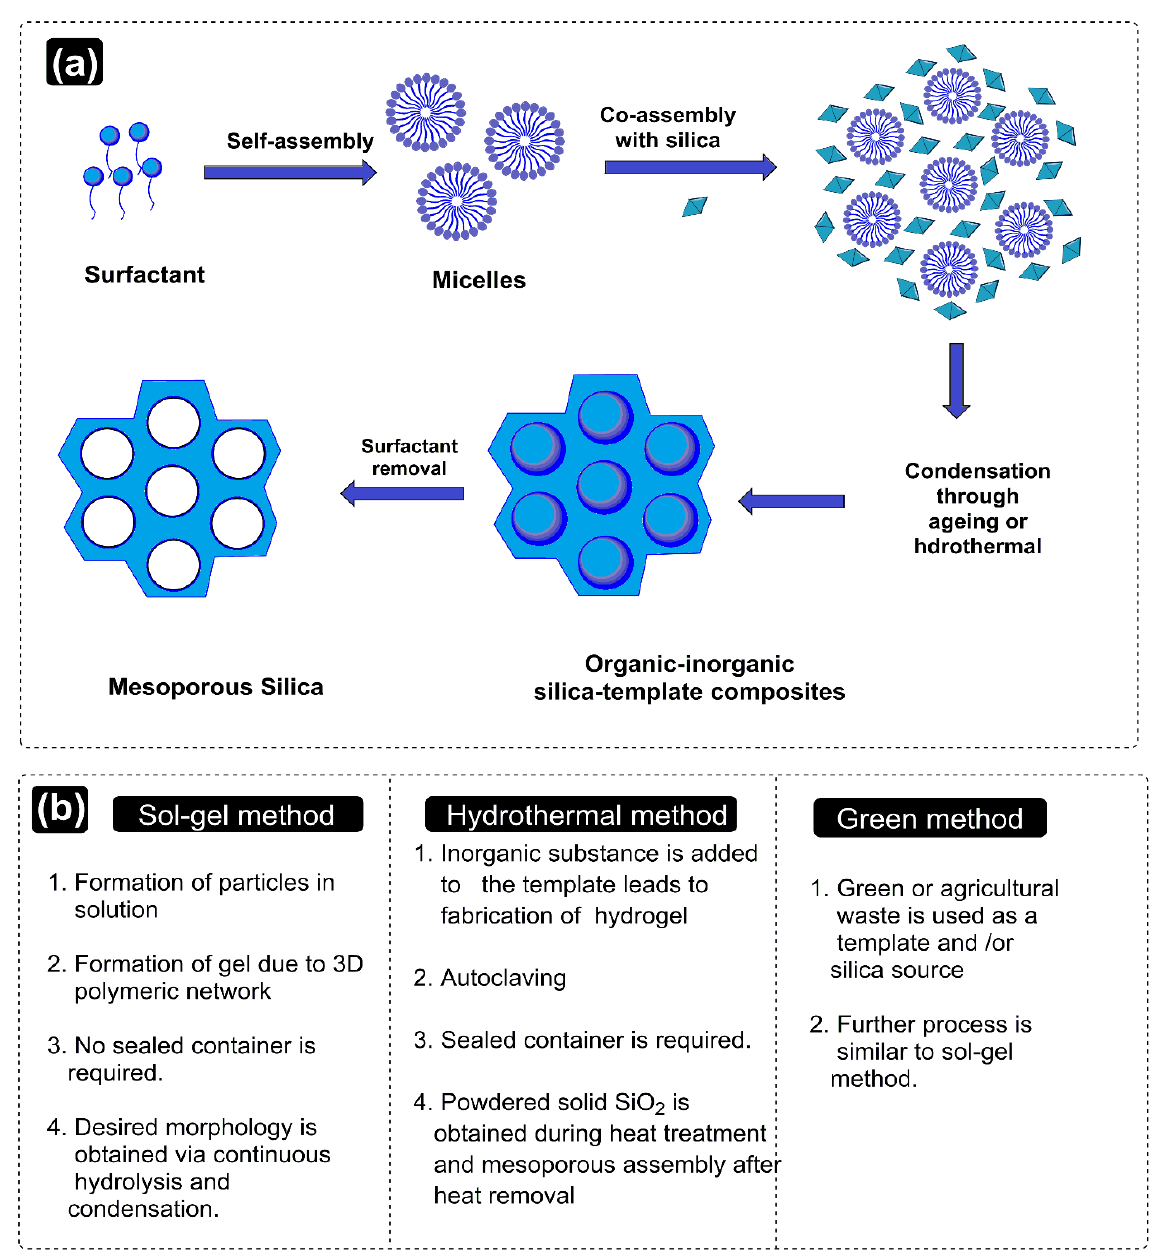
Figure 3. ( a )Representative stages for surfactant – template-mediated fabrications of mesoporous sil- Figure 3. ( a ) Representative stages for surfactant–template-mediated fabrications of mesoporous ica nanoparticles. ( b ) Distinguishing features of sol – gel, hydrothermal and green methods. silica nanoparticles. ( b ) Distinguishing features of sol–gel, hydrothermal and green